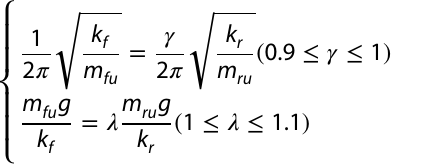
Fig. 6 Dynamic simulation optimization method Table 2 The design variables